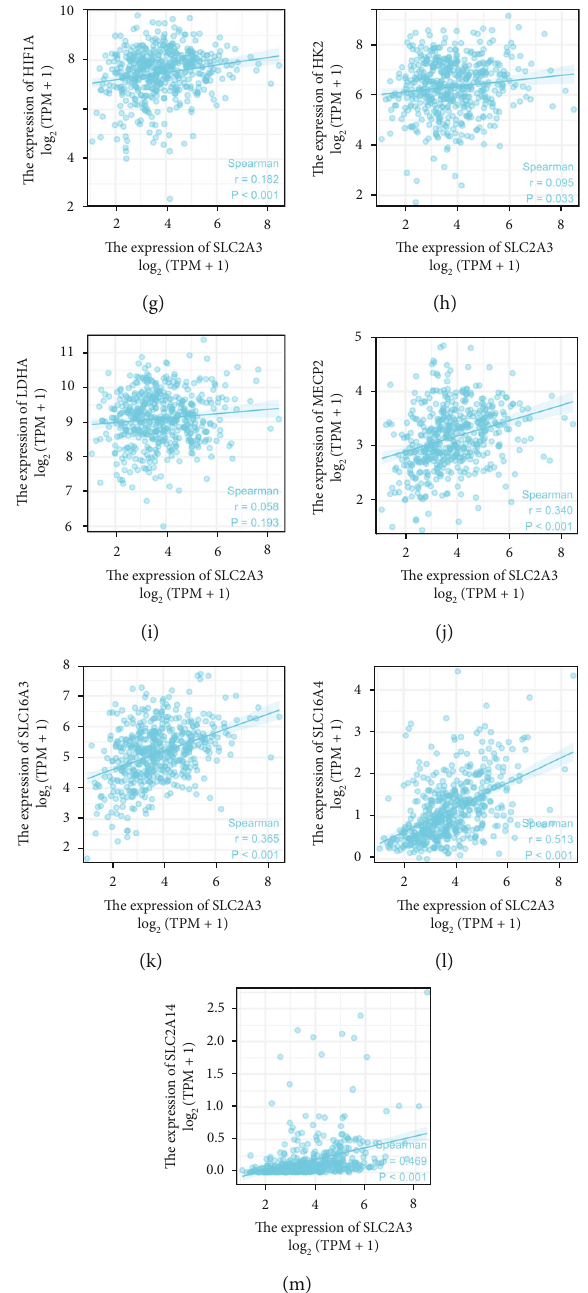
Figure 6: SLC2A3 coexpression networks and enrichment analyses. Coexpression genes of SLC2A3 analyzed by Pearson test based on LinkedOmics database (a). Top 50 positive coexpression genes (b). Top 50 negative coexpression genes (c). PPI networks associated with SLC2A3 (d). Enrichment analysis of nine coexpression genes (e). Correlation analyses between SLC2A3 and coexpression genes (f –